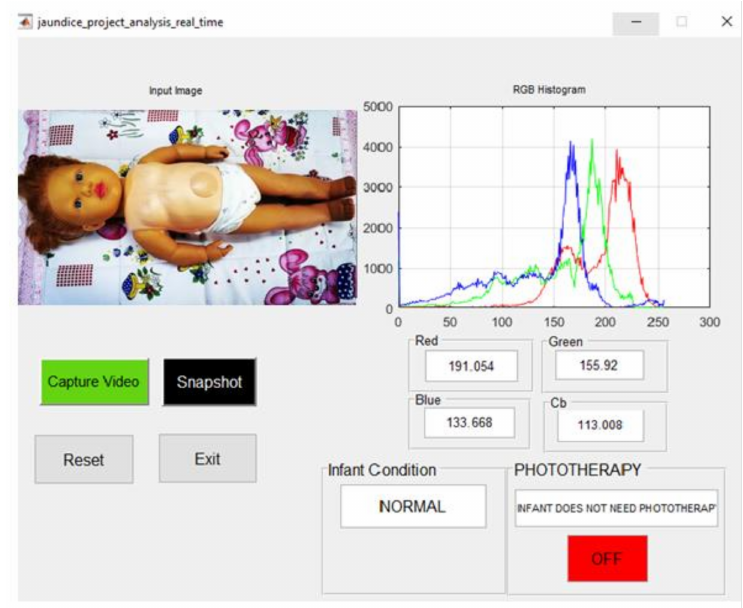
Figure 9. A manikin with brown skin color and jaundice-free. In the last case, a manikin with yellowish brown skin was used, which represents the case of a jaundiced brown skinned infant. Figure 10 depicts how the proposed system detects that the manikin has jaundice and needs phototherapy. This diagnosis is based on the mean values of the B and Cb channels which are higher than the threshold value specified by the system. As clarified earlier, the blue LED inside the incubator is switched ON and an SMS message is sent to the care provider.